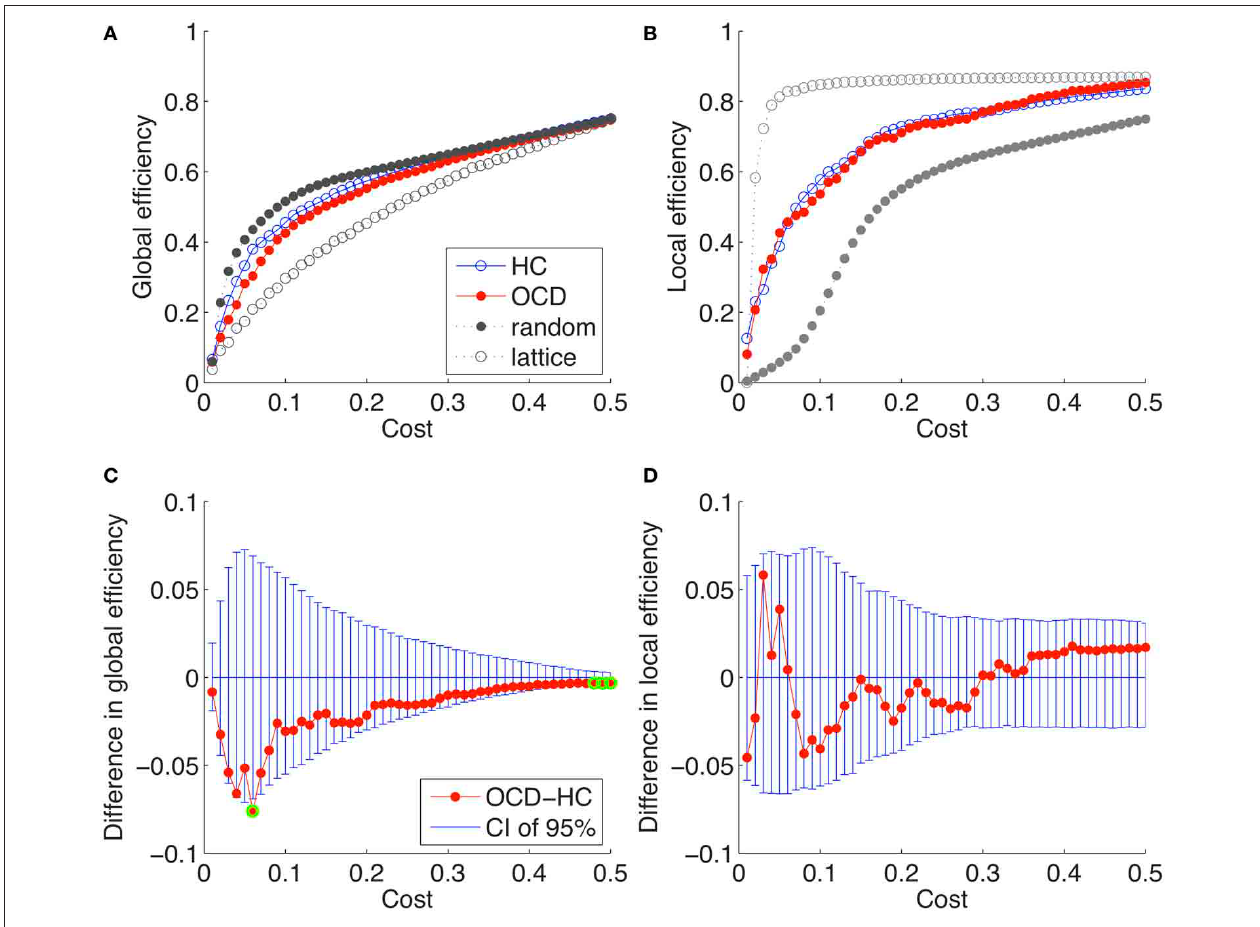
FIGURE 2 | Global efficiencies and local efficiencies of the brain networks of the controls (HC), and the OCD patients (OCD) are plotted over variant rewiring costs with the ones of random and lattice networks with matched costs (A,B). The differences between the OCD